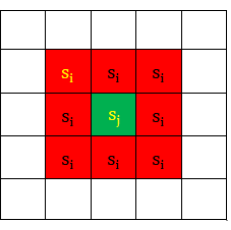
Figure 5. Diagram of structural elements state.